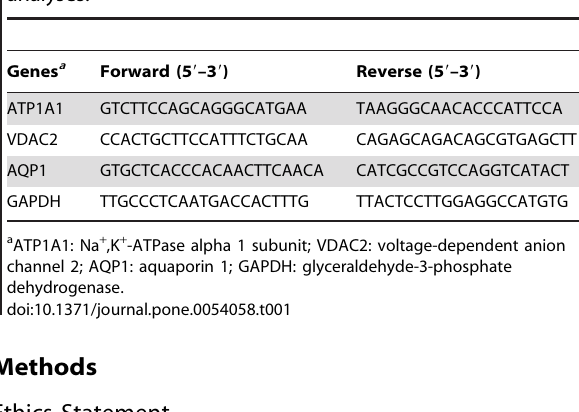
Table 1. Sequences of primers used in gene expression